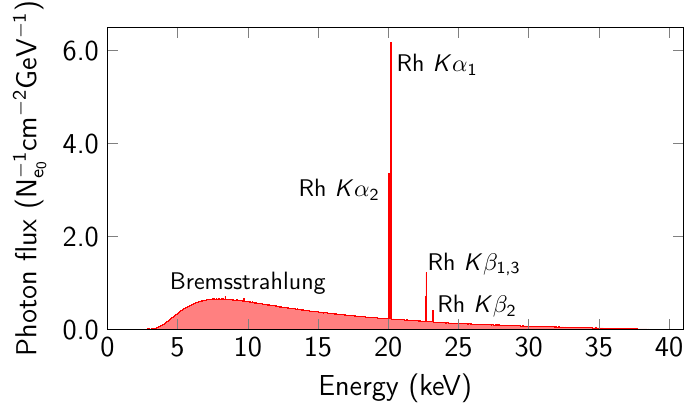
Figure 2. Rh anode X-ray